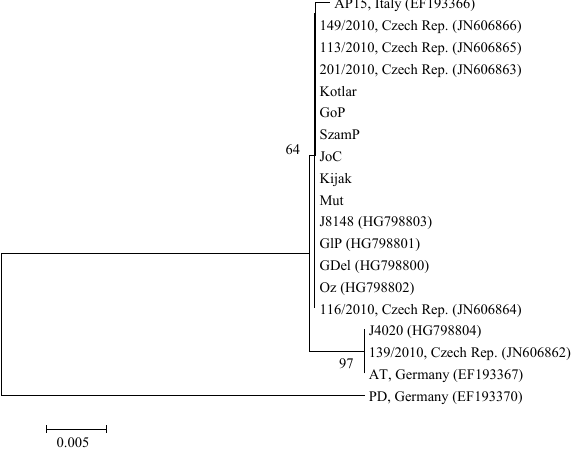
Figure 6. Phylogenic analysis of the S10 ribosomal protein sequences of 11 ‘ Ca. P. mali’ strains detected from a survey of apple trees in Central and Southern Poland during 2010- 2013 and the strains available in GenBank. PD strain of ‘ Ca . P. pyri’ (EF193370) was included as outgroup. Phyloge - netic trees were constructed by the neighbour-joining al - gorithm (MEGA 4.0) and the Kimura 3-parameter nucleo - tide substitution model in using 1,000 bootstrap replicates. Only bootstrap values higher than 60 are shown. The bar indicates the genetic distance as Kimura